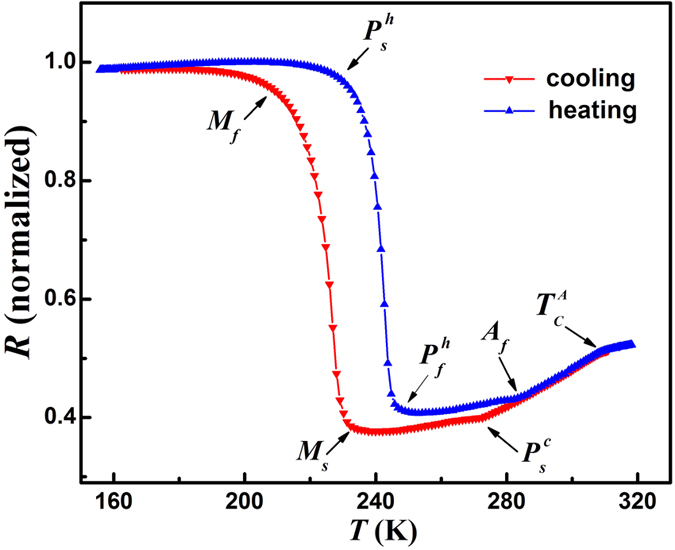
Temperature dependence of resistance R(T) for Ni50Mn34In15.5Al0.5 alloy at zero field upon heating and cooling.